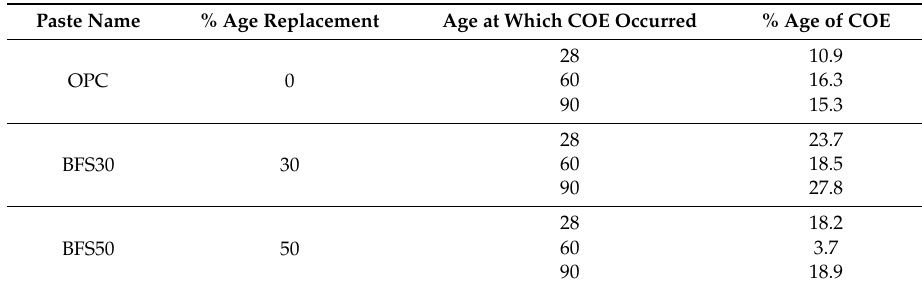
Figure 6. Compressive strength (MPa) at various water curing temperatures and ages for OPC and slag blended cement mortars (BFS30 and BFS50). Table 3. COE records with 20–60 °C increase in water curing temperature at ages up to 90 days for OPC and slag blended cement mortars